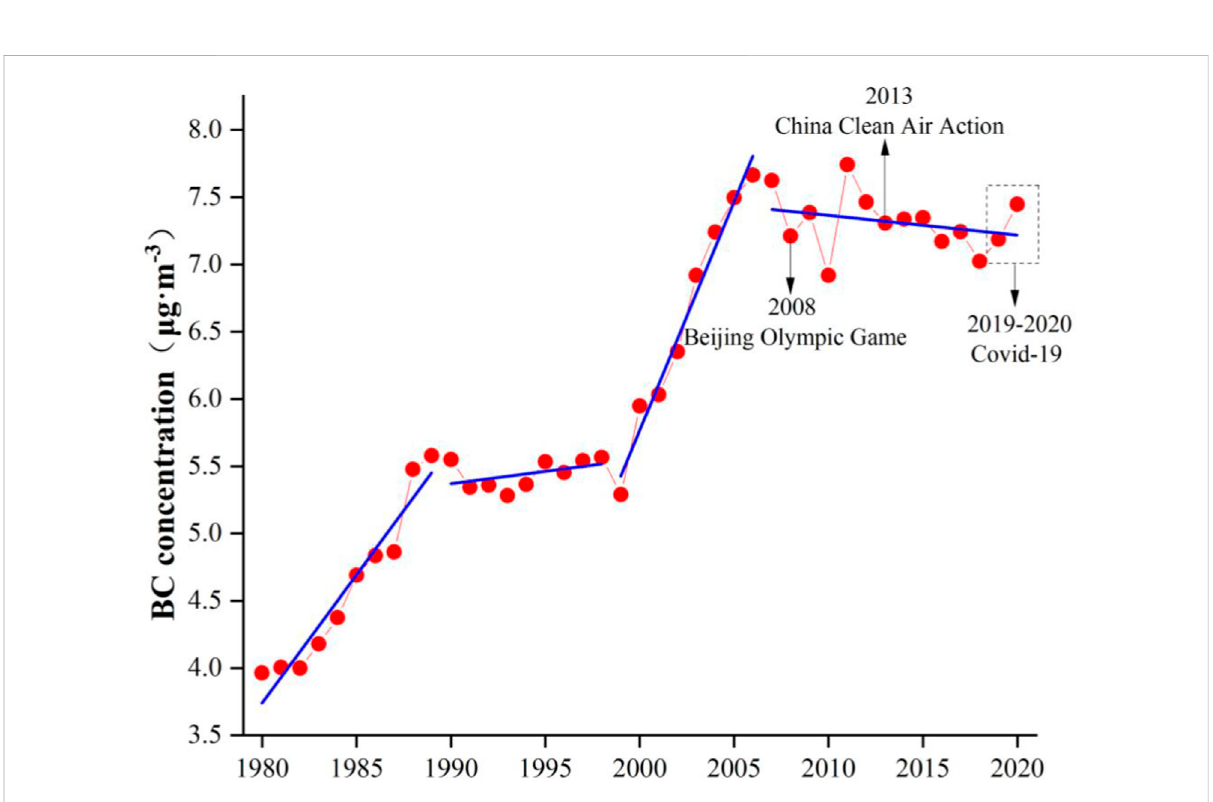
FIGURE 3 Trend in BC concentration from MERRA-2 data from 1980 to 2020 at